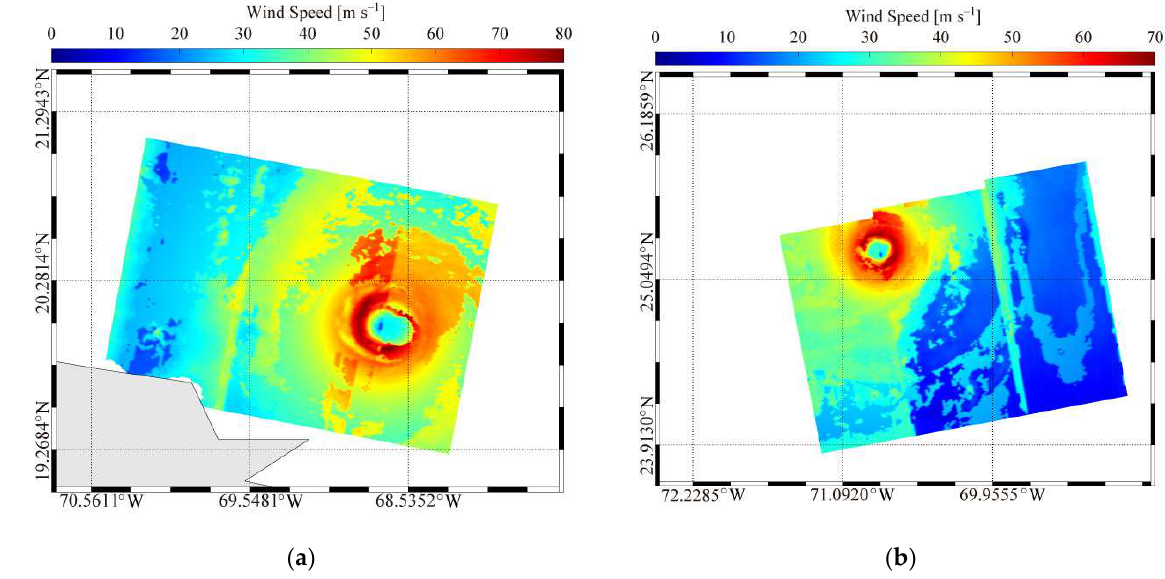
Figure 9. Wind speed in two radial profiles on the images of TC Irma overlaid by radial-vortex modeling winds at two flow directions: ( a ) 45 ◦ and ( b ) 135 ◦ . The red curve is the VH-polarized SAR-derived without rain, the blue curve is with rain and the black line is the model-simulated result.